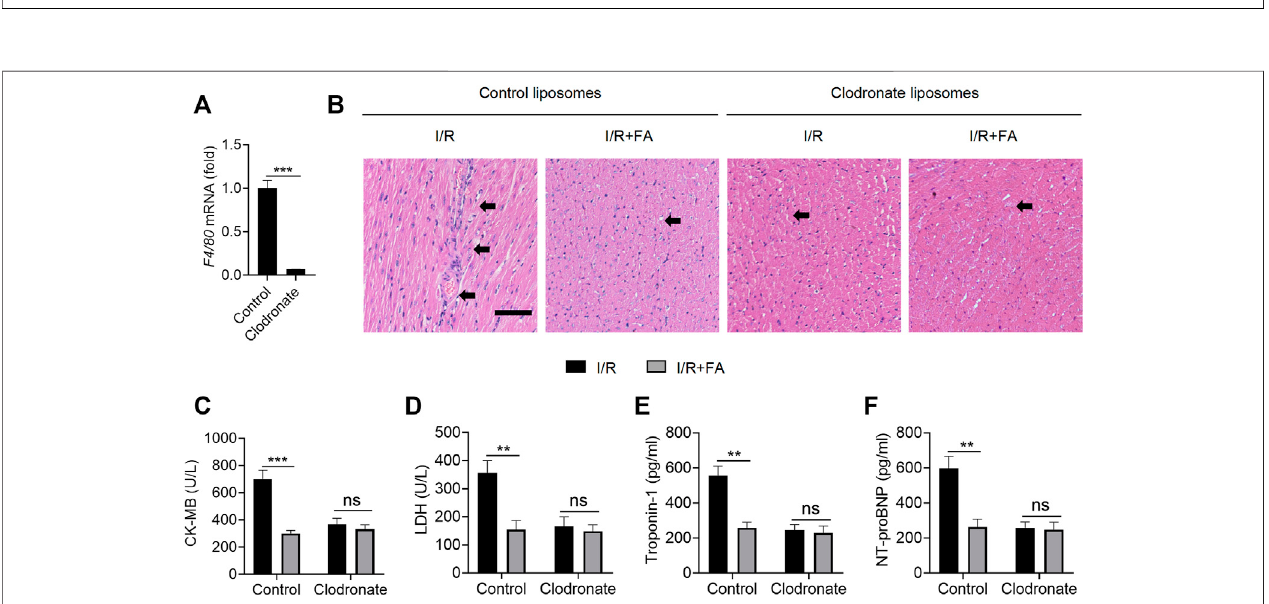
FIGURE 7 | Macrophage clearance inhibits the myocardial protective effect of FA. (A) The mRNA expression of F4/80 in the heart tissue of WT mice treated with clodronateliposomeswasdetected byRT-PCR. (B) HEstainingofhearttissuesectionsineachexperimental groupaftertreatmentwithclodronateliposomesorcontrol liposomes. (C – F) Expression of CK-MB, LDH, troponin-1, and NT-proBNP in the serum of each experimental group after treatment with clodronate liposomes and control liposomes. Data are expressed as the means ± sd from three independent experiments. ** p < 0.01, *** p < 0.001; ns indicates no signi fi cance.